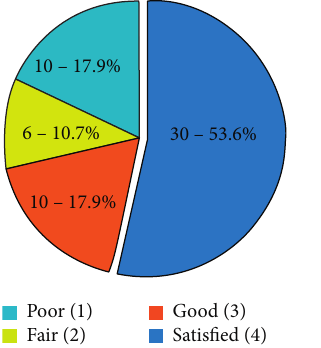
Figure 2: Patient satisfaction scores and